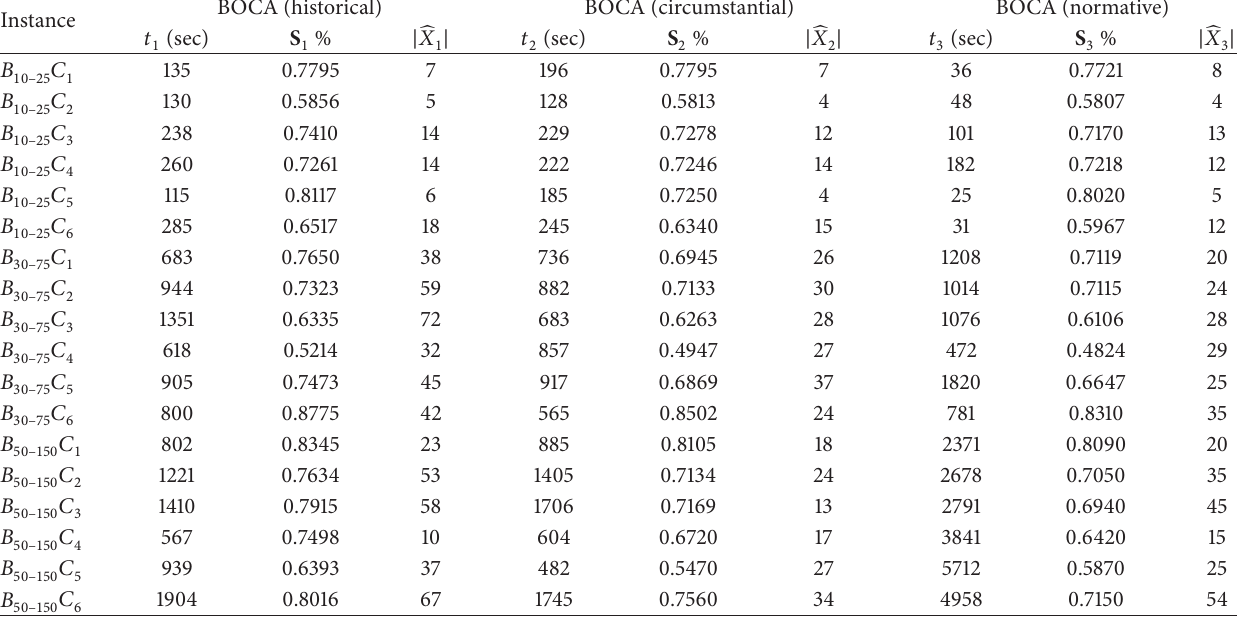
Table 2: Results obtained by the BOCA implementations for instance of class 𝐵